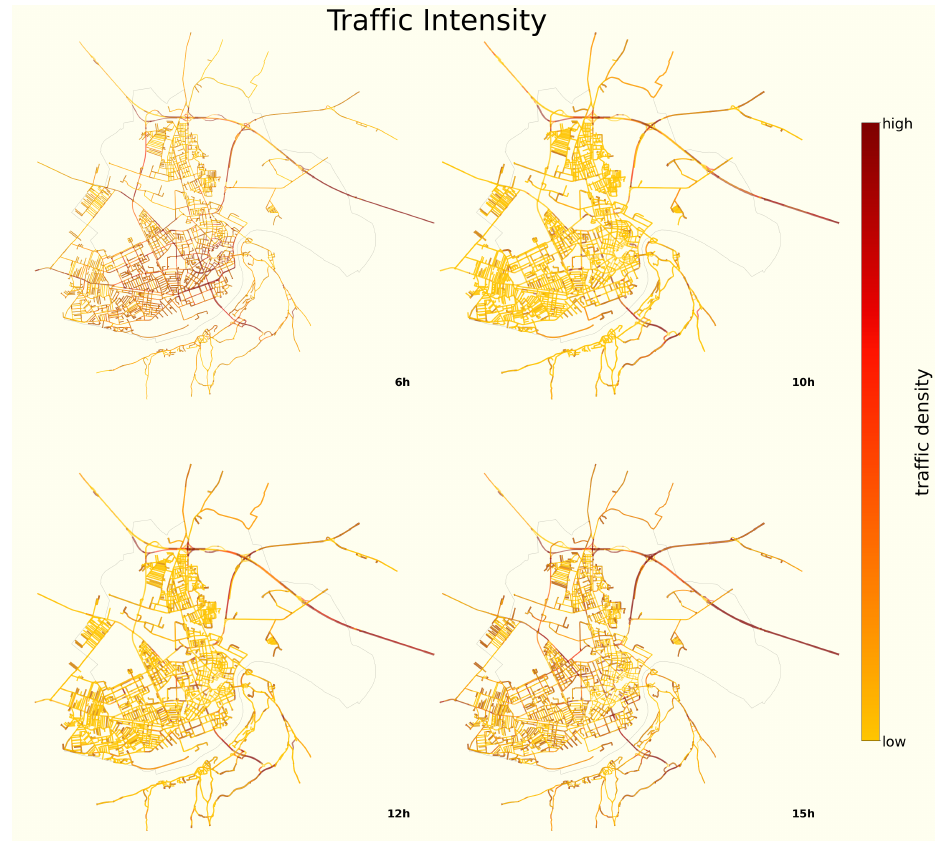
Figure 7. Traffic density at different